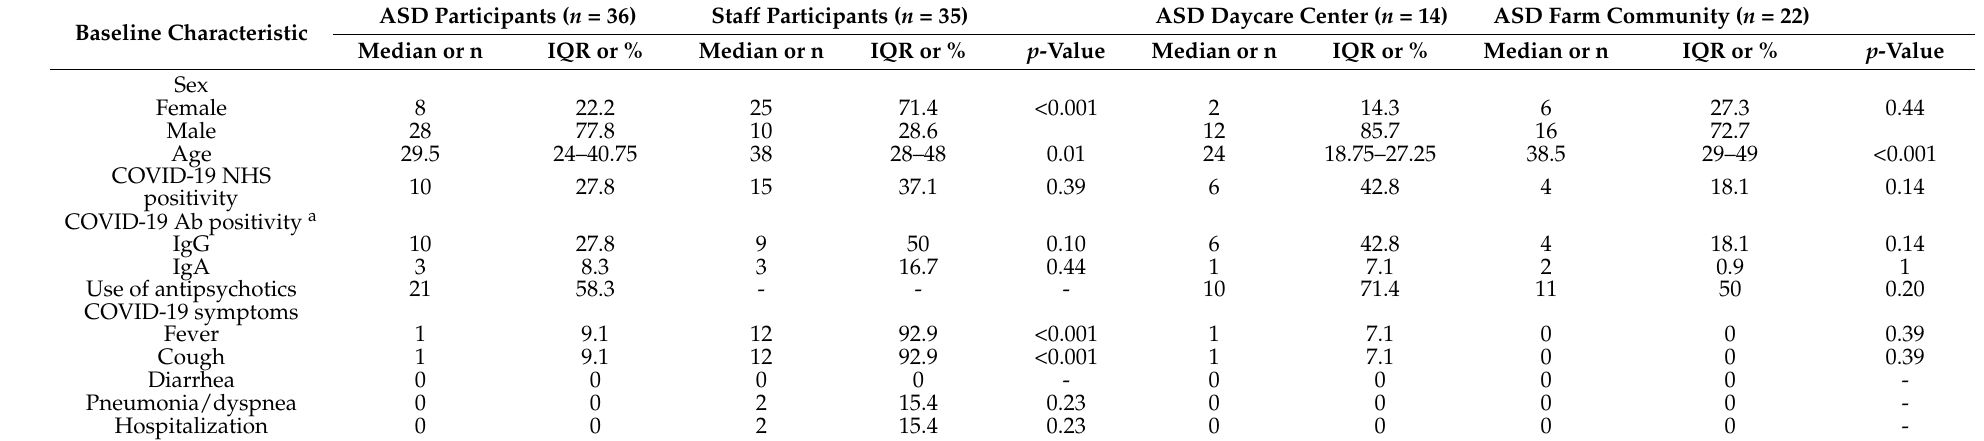
Table 1. General characteristics of the